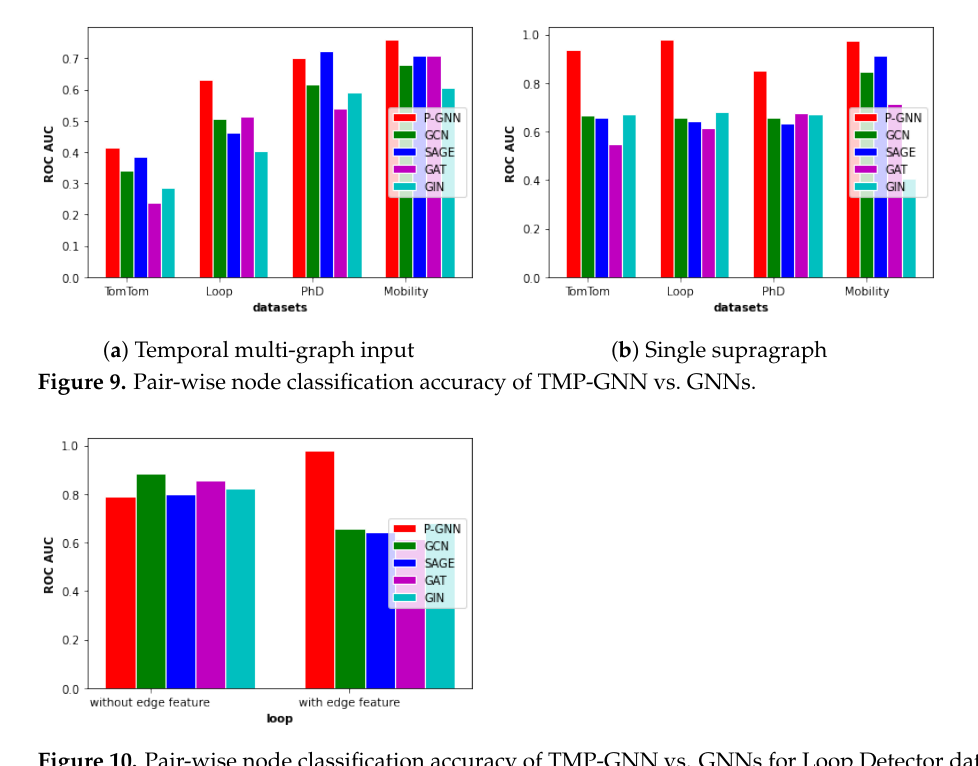
Figure 10. Pair-wise node classification accuracy of TMP-GNN vs. GNNs for Loop Detector dataset with and without edge feature.